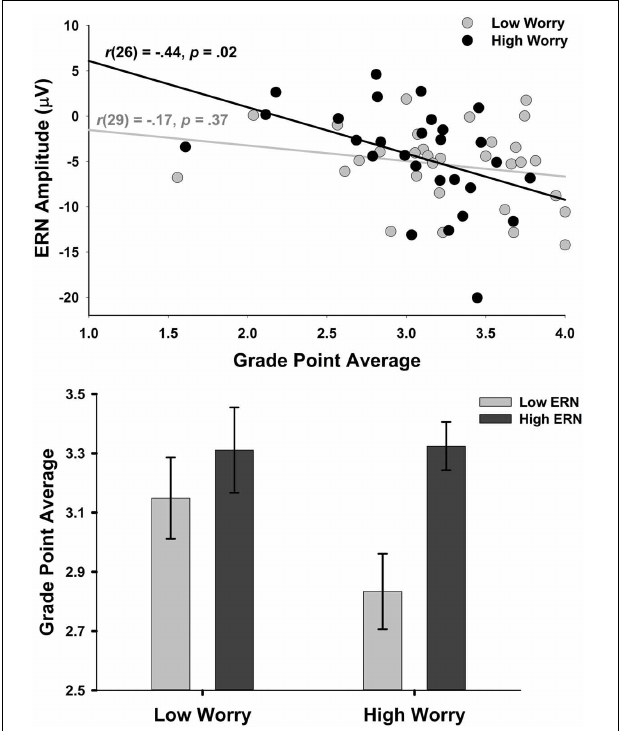
FIGURE 7 | Relationship between ERN and GPA is moderated by worry. (Top) Scatterplot showing the relationship between ERN and GPA in the top 50% of the PSWQ distribution (black) and the bottom 50% (gray). (Bottom) Bar graph depicting GPA as a function of ERN and Worry groups which were created by median splits and described in the text. Error bars represent standard error of the